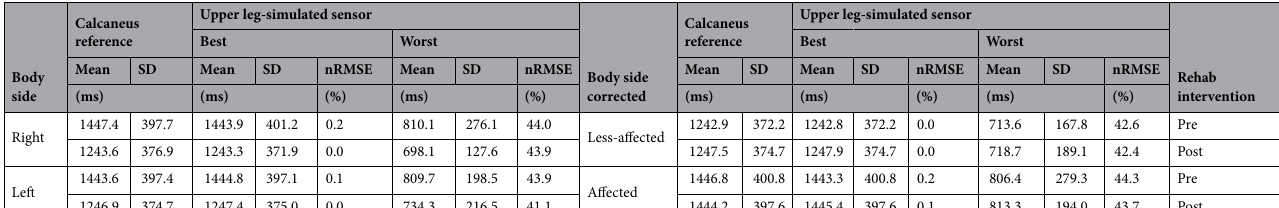
Table 2. Comparison of best and worst performing simulated sensor position to estimate the gait marker stride duration in the patient study. Mean, std. dev. (SD), and relative error (nRMSE) of all strides were derived for both body sides and corrected for affected and less-affected sides in pre- and post-intervention,